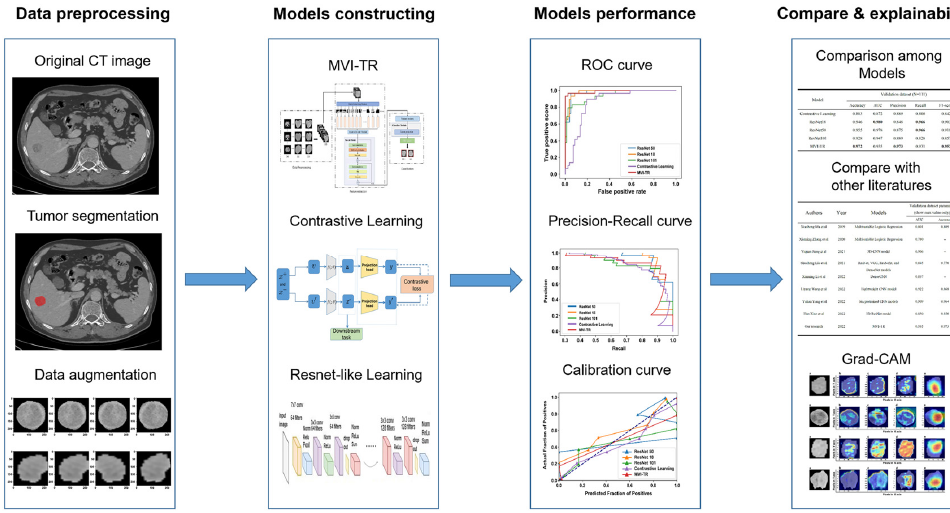
(Table 1). For clinical outcomes and baseline variables, there were no significant differences between the training and validation cohorts (all p > 0.05).